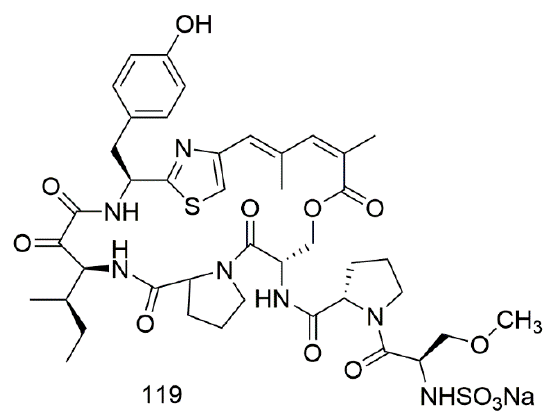
Figure 9. Peptide alkaloids from sponge. Table 9. Cytotoxic activity of peptide alkaloid.